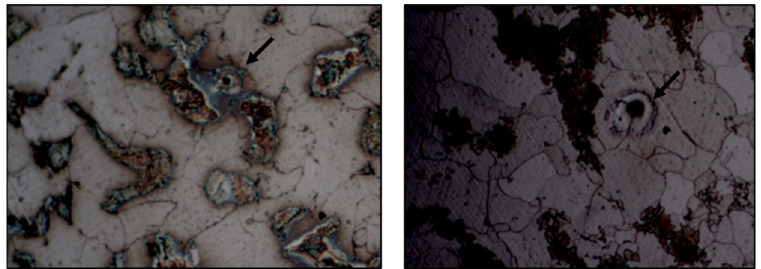
× ) and 3 ( right , 1000 × ).